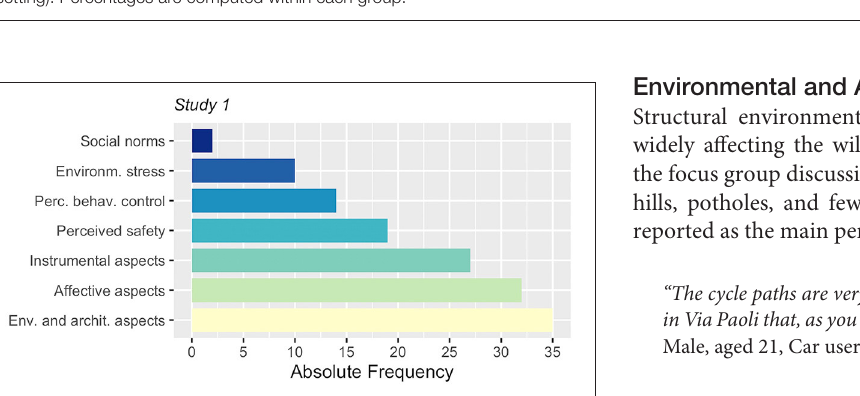
FIGURE 1 | Positive and negative frequencies of sentences associated with different means of transport and with architectural and environmental aspects (i.e., setting). Percentages are computed within each group.